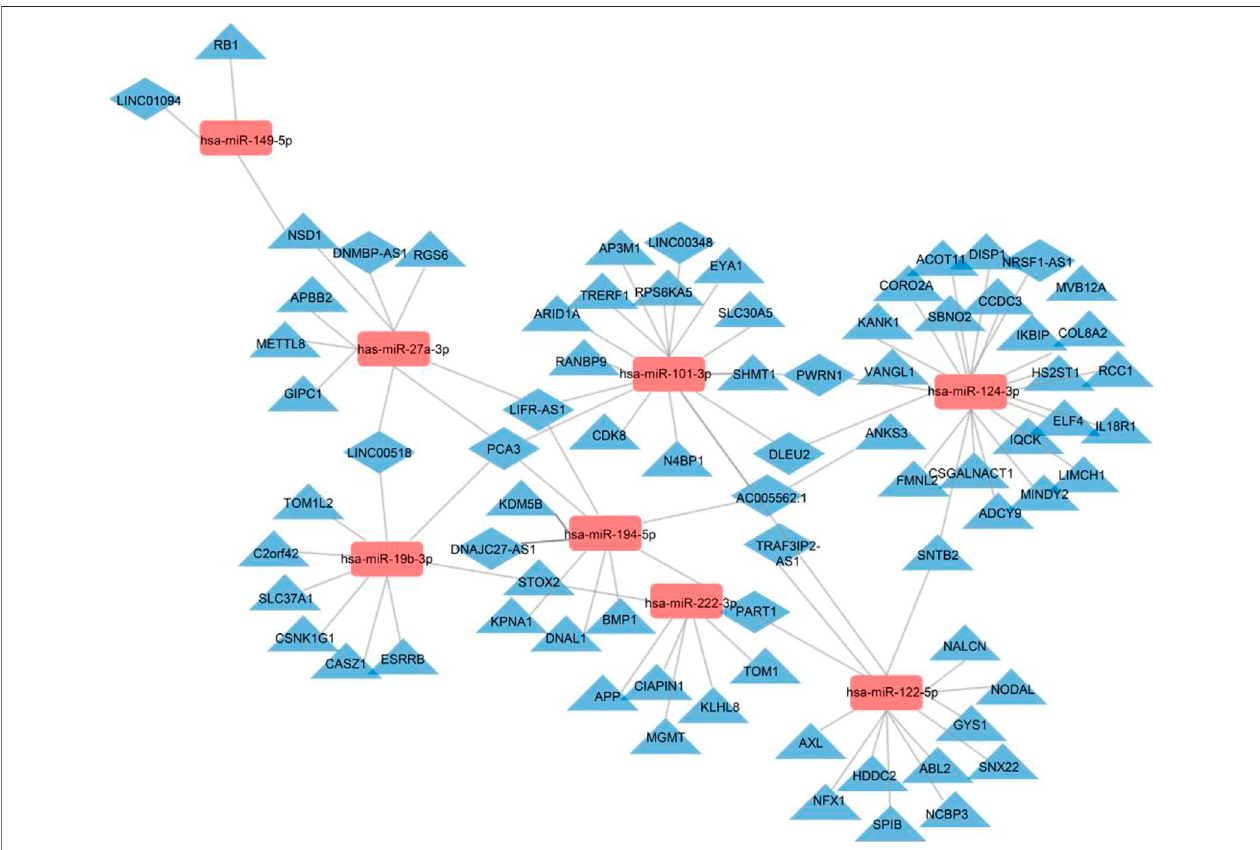
FIGURE 6 | Regulatory network of the DE-mRNAs – DE-miRNAs – DE-lncRNAs in MetS. DE-mRNAs, DE-miRNAs, and DE-lncRNAs are indicated by triangles, rectangles,anddiamonds,respectively.Theredrectanglesrepresenthighexpressionlevels,andbluetrianglesanddiamondsrepresentlowexpressionlevels.Graylines indicate lncRNA – miRNA – mRNA